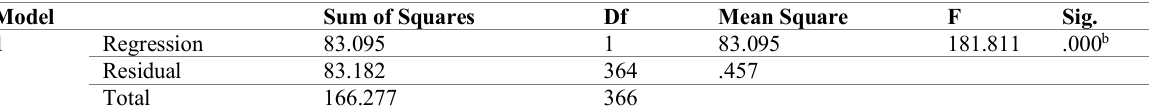
Table 4: ANOVA test for participative leadership style